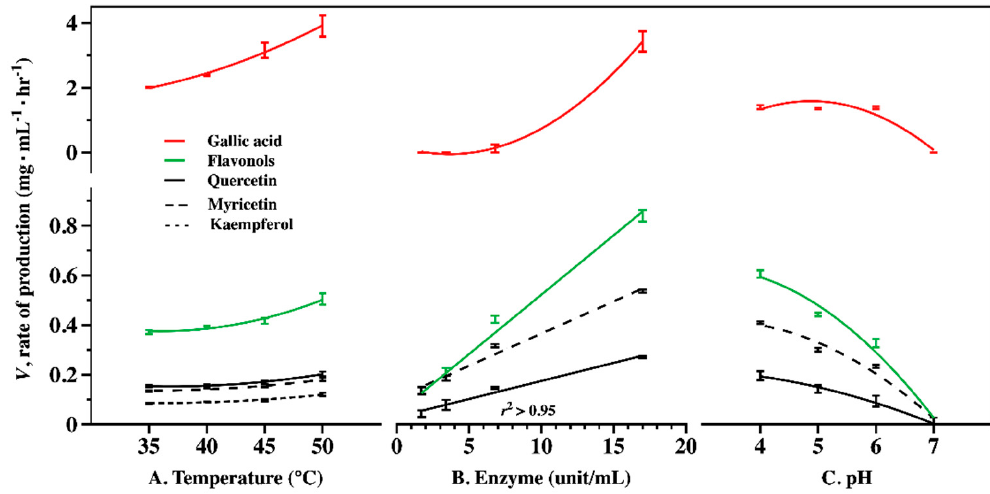
Figure 3. E ff ects of ( A ) temperature, (B) enzyme amount, and ( C ) pH on production of flavonol Figure 3. Effects of (A) temperature, (B) enzyme amount, and ( C ) pH on production of flavonol aglycones and gallic acid from green tea extract in enzyme CF aglycones and gallic acid from green tea extract in enzyme CF reaction.